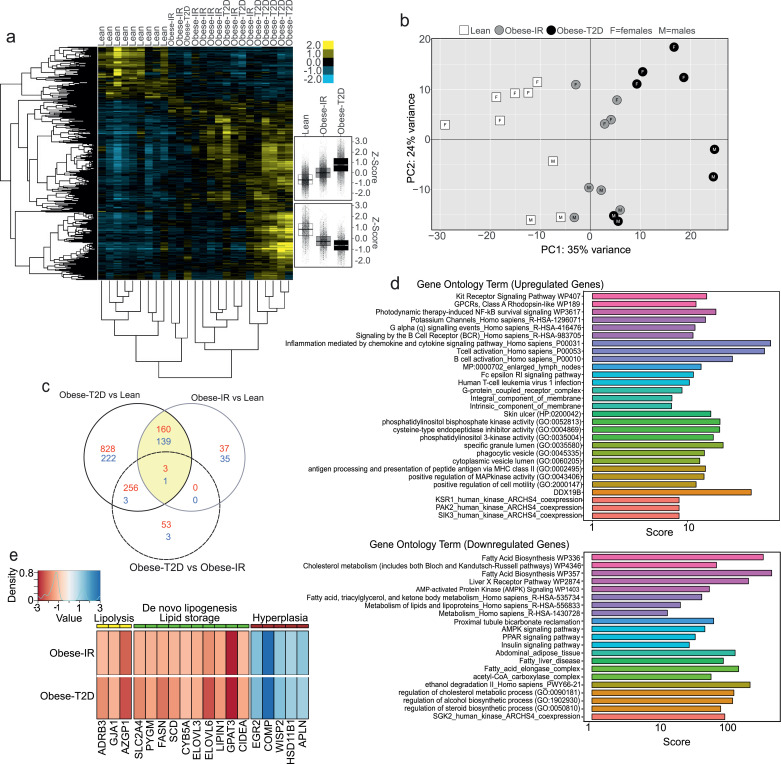
Adipose tissue RNA sequencing analysis in the MD-Lipolysis study.(a) Heat map showing the differentially expressed genes (log Fold change). Two main clusters of genes were obtained: one of genes upregulated and one of genes downregulated in the Obese groups. In the right panel, a box plot of these two gene clusters in the three categories [variance stabilizing transformation, FDR/Benjamini-Hochberg]. (b) Principal component analysis (PCA) of gene expression counts (normalized as in a). Groups and sex of participant are indicated. (c) Venn diagram of genes differentially expressed in the three comparisons. The number of differentially genes for each subgroup is indicated in red for downregulated and blue for upregulated. (d) Bar plots graph of the enrichment of ontology terms based on the combined score calculated by the EnrichR web tool. A selection of no more than the first five elements for each gene set databases is shown. Colour indicate the gene set database in Supplemental Material Figure 5a. All terms have multiple tests correction adjusted p-value less than 0.05 [FDR/Benjamini-Hochberg]. (e) Heat map of genes selected by literature search of all the core differentially expressed obesity genes identified by the Venn diagram (yellow area in c).